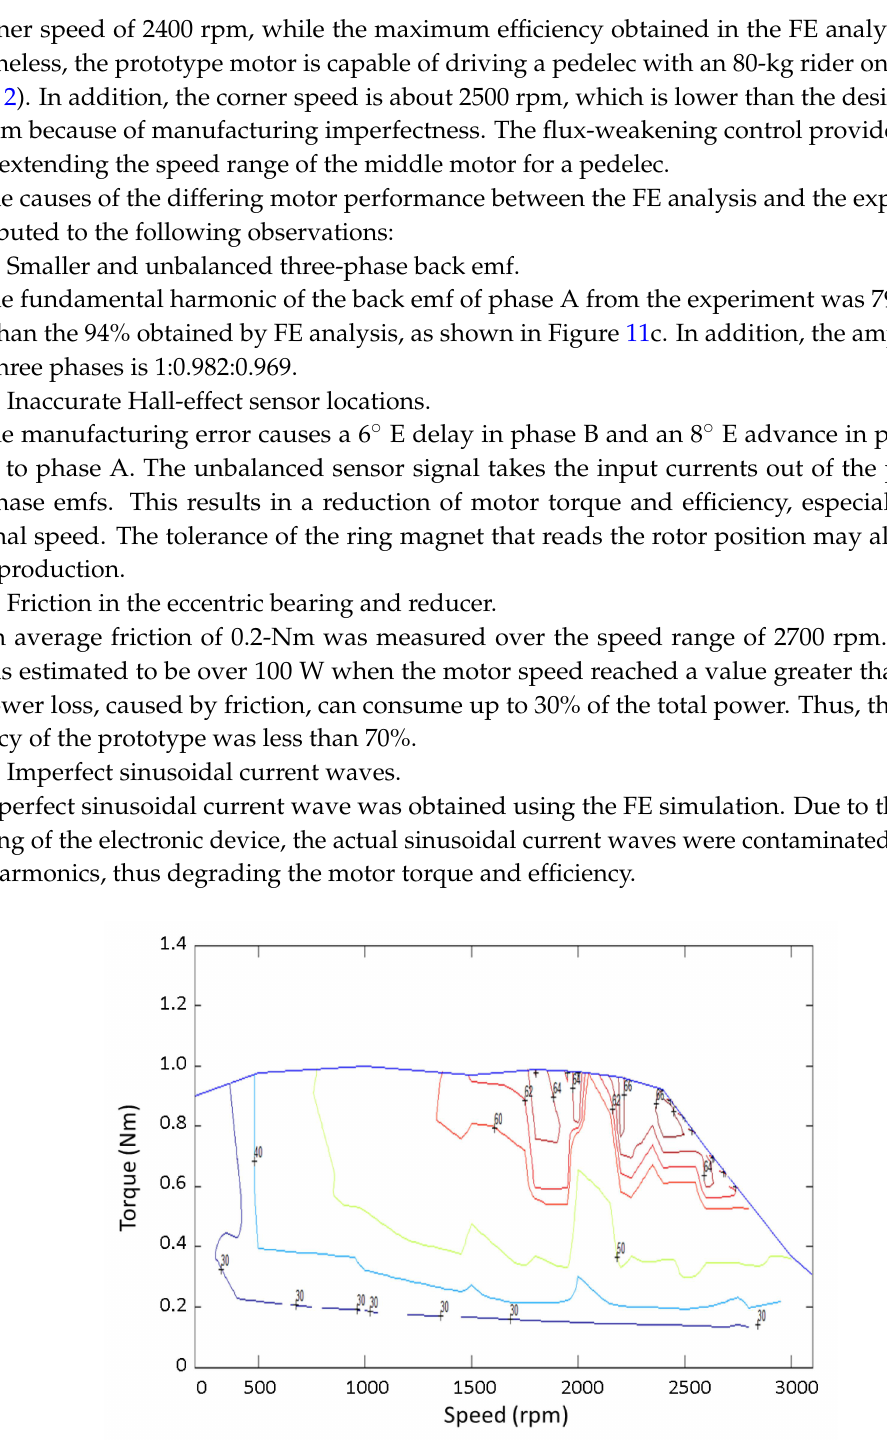
Figure 12. The torque, speed, and efficiency map of the AFPM motor